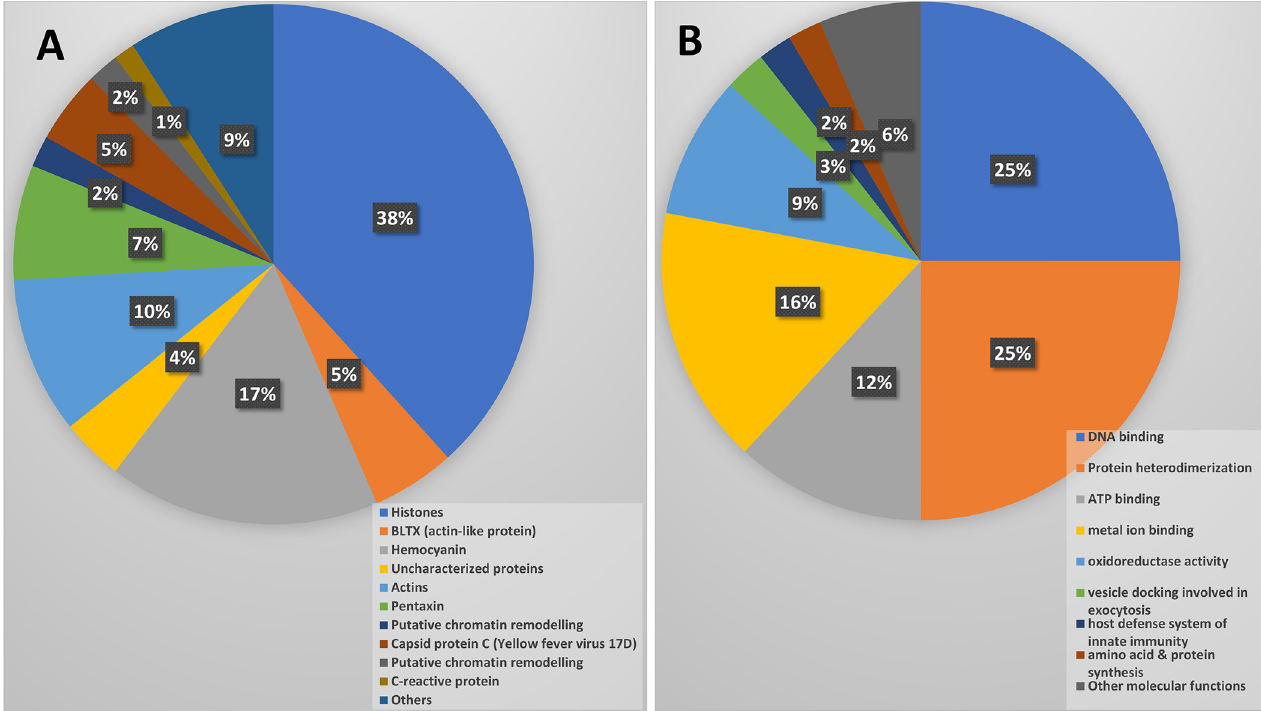
Fig 1. Combined classification of hemocytes proteins from LPS-stimulated and non-stimulated T . gigas samples. (A) Different types of proteins of the hemocytes of T . gigas . (B) The distribution of proteins with molecular and biological functions identified in the hemocytes of T . gigas .